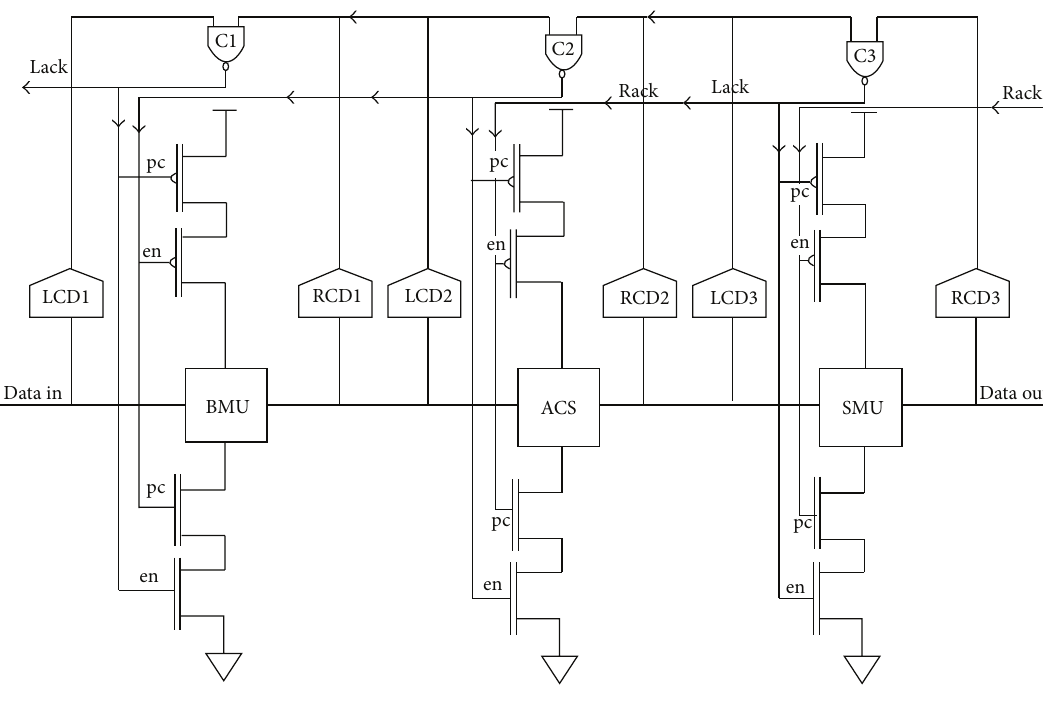
Figure 4: Integrated design of asynchronous Viterbi decoder.